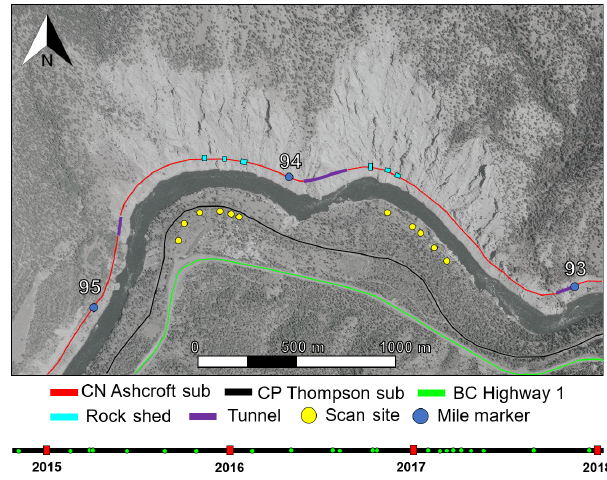
Figure 3. Overview of the scan site locations from across the Thompson River. The timeline across the bottom of the figure in- dicates the times when TLS scans were captured (green